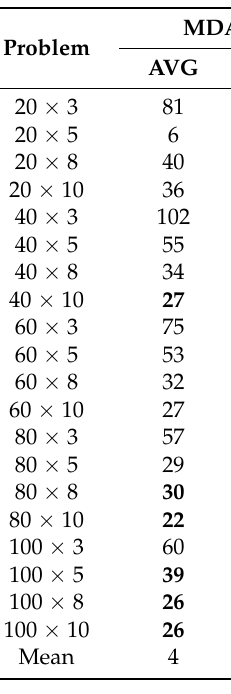
Table A7. N -metrics for the four algorithms.